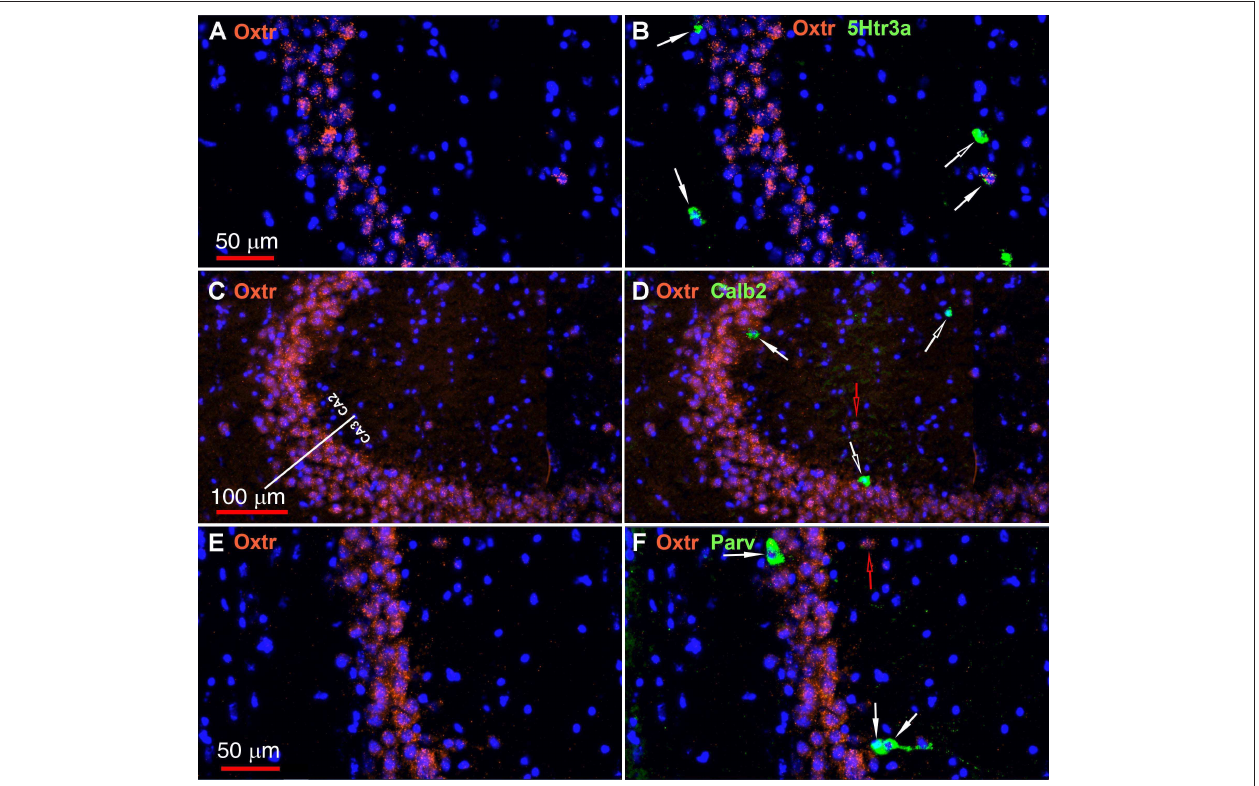
FIGURE 6 | Examples of the distribution of Oxtr within the CA2 hippocampal region. (A) shows Oxtr expression in the CA2 and (B) shows its colocalization with 5Htr3a transcripts. (C) shows Oxtr expression in the CA2 and (D) shows expression with Calb2 transcripts. (E) shows Oxtr expression in the CA2 and panel F shows its colocalization with Parv transcripts. Scale bars in (A) 50 µ m, (C) 100 µ m, and (E) 50 µ m are also for (B,D,F) , respectively. Solid white arrows indicate colocalization of Oxtr transcripts with the INM transcripts. Open white arrows indicate only expression of the INM. Open red arrows indicate only expression of Oxtr.